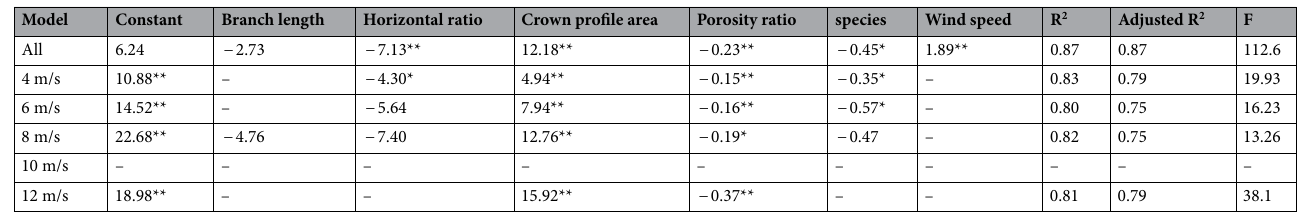
Table 3. The results of stepwise regression by “both direction” method. p < 0.05 labelled as *; p < 0.01 labelled as